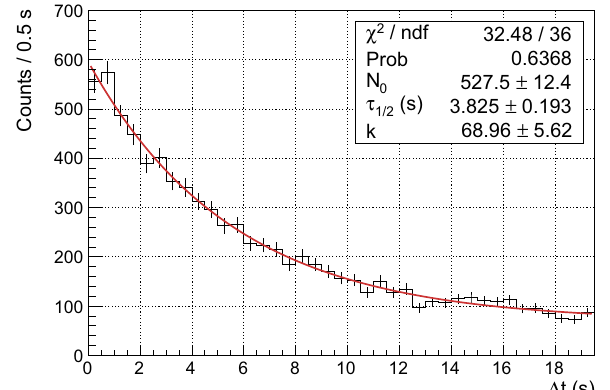
Fig. 4 Distribution of the time intervals between 223 Ra– 219 Rn decays, interpolated with an exponential function plus a flat background to account for random delayed